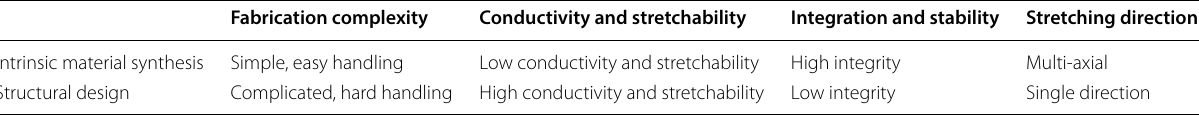
Table 1 Comparison between two approaches fabricating stretchable electronics based on ways of mechanically geometric design and material